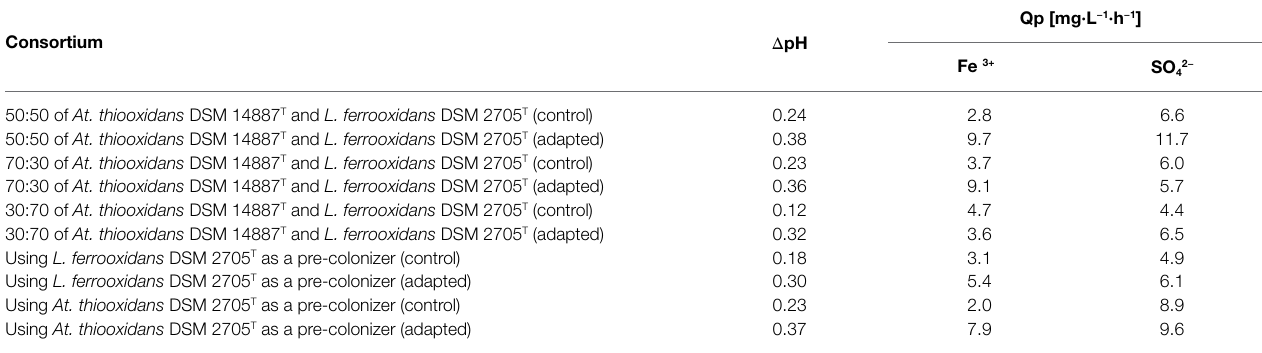
TABLE 2 | pH variation and overall volumetric productivities of the different consortia formed by the species At. thiooxidans DSM 14887 T and L. ferrooxidans DSM 2705 T .